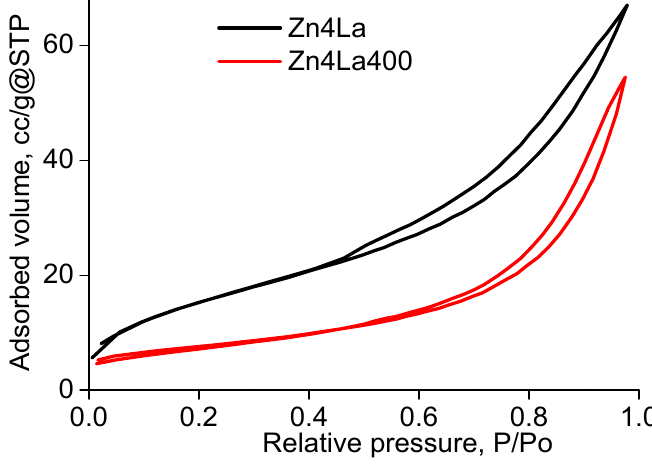
Figure 5. BET isotherms of the samples.